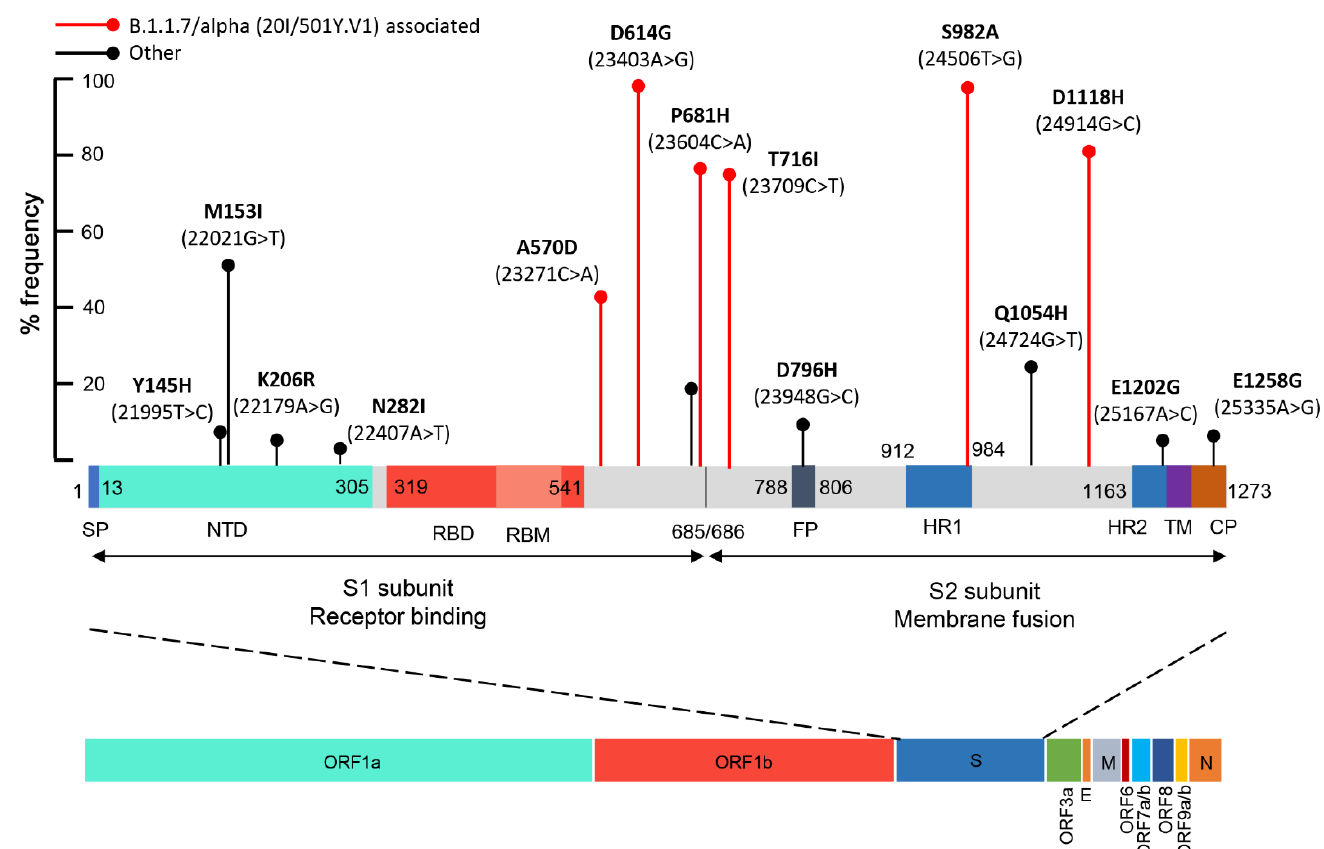
Figure 6. Schematic illustration of % frequency of missense mutations across the entire S gene colored by domain. Domains that are not visualized in the final map are colored grey. Numbers indicate amino acid residues. Β .1.1.7/alpha (20I/501Y.V1) associated missense mutations are indicated by red. SP, signal peptide; NTD, N-terminal domain; RBD, receptor-binding domain; RBM, receptor-binding motif; FP, fusion peptide; HR1, heptad repeat 1; HR2, heptad repeat 2; TM, transmembrane domain; CP, cytoplasmic peptide.